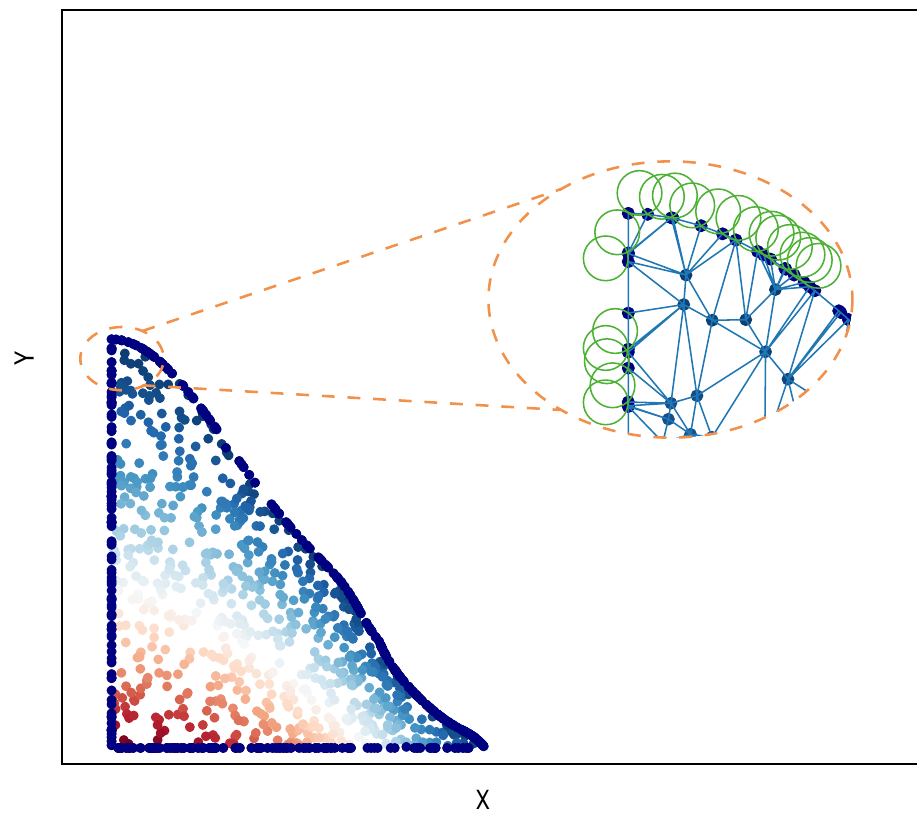
Figure 1. Illustration of examples for surface particle identification based on two-dimensional alpha-shape